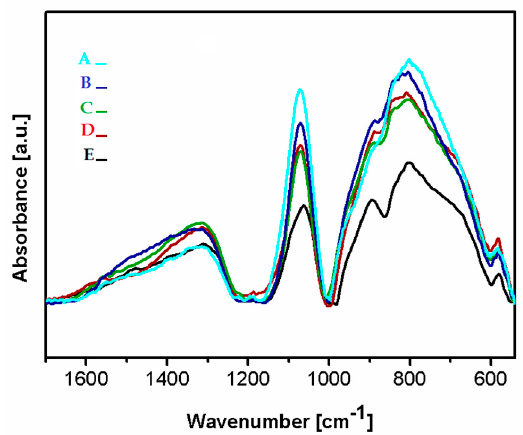
Nanomaterials 2019 , 9 , x FOR PEER REVIEW 10 of 16